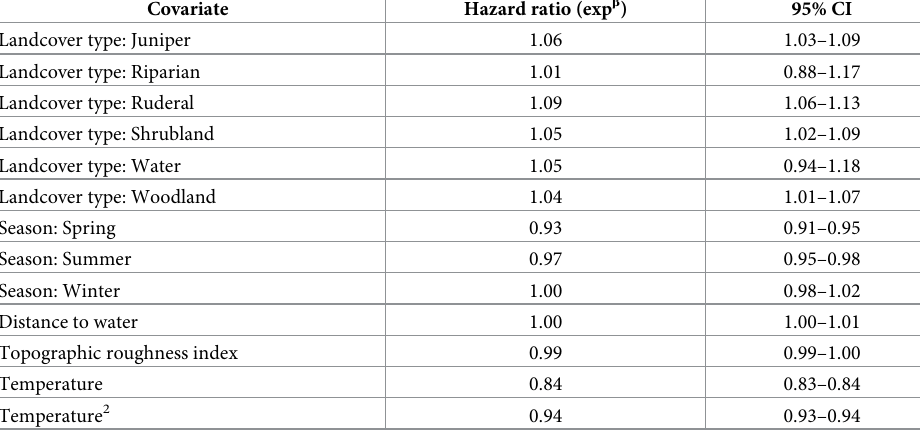
Table 4. Hazard ratios and their associated 95% confidence intervals (CI). Confidence intervals not overlapping 1 indicate an effect of that covariate. Land cover types and seasons are categorical variables where hazard ratios are in ref- erence to the base category. The base landcover category is grassland, and the base season is fall. Covariate Hazard ratio (exp β )